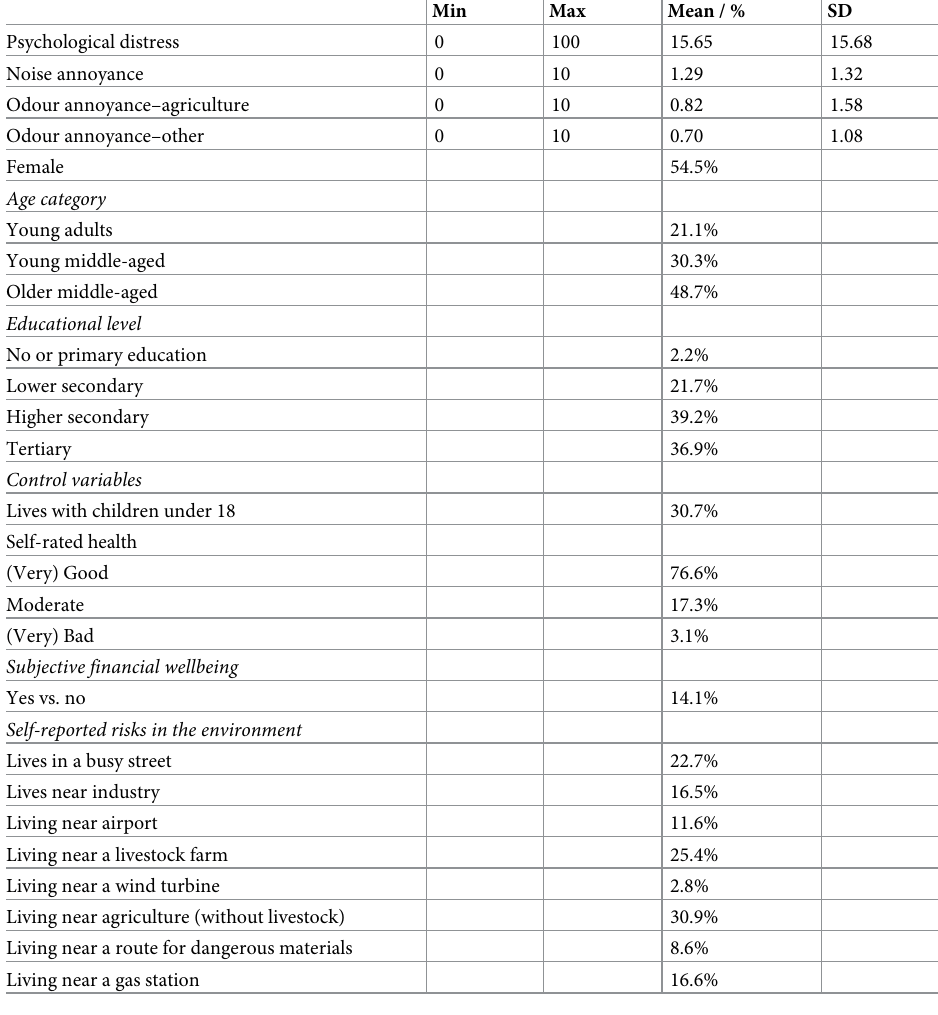
Table 1. Descriptive statistics of all variables (n =